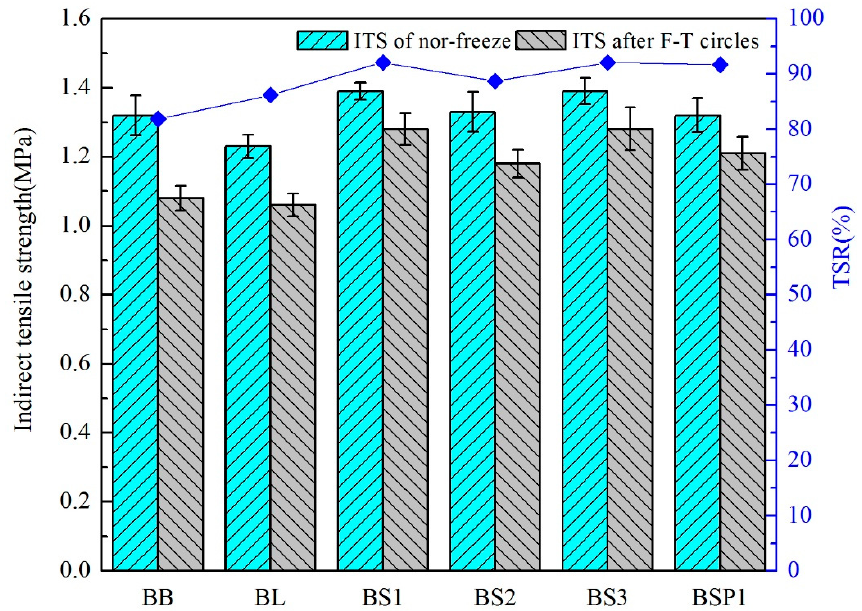
Figure 11. Splitting test results with different coarse aggregates.